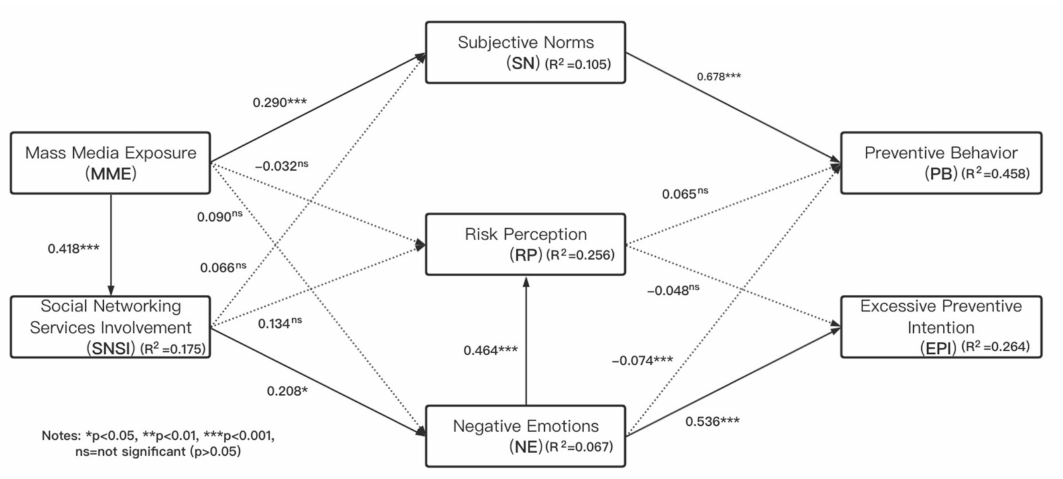
Figure 2. Results of the structural model analysis for the Wuhan group.